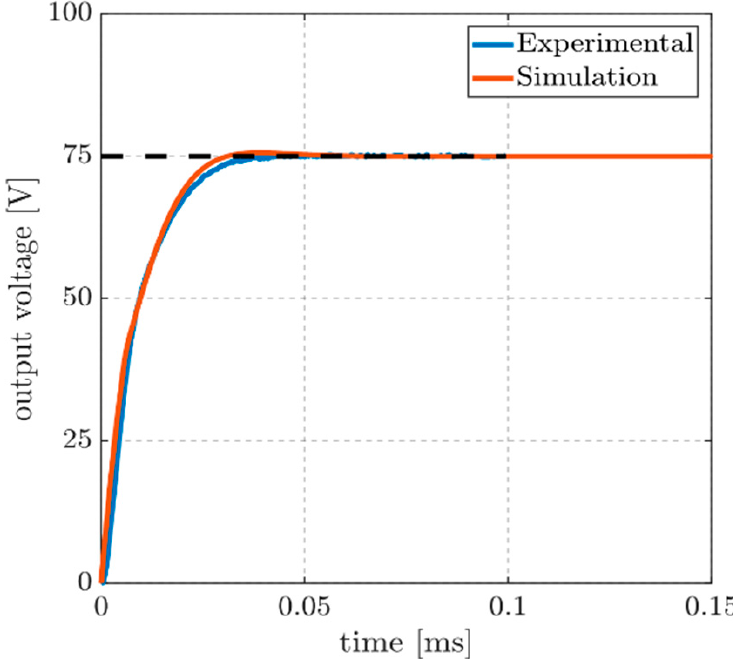
Figure 18. Step voltage response of the proposed SPS control, experimental vs. simulation.